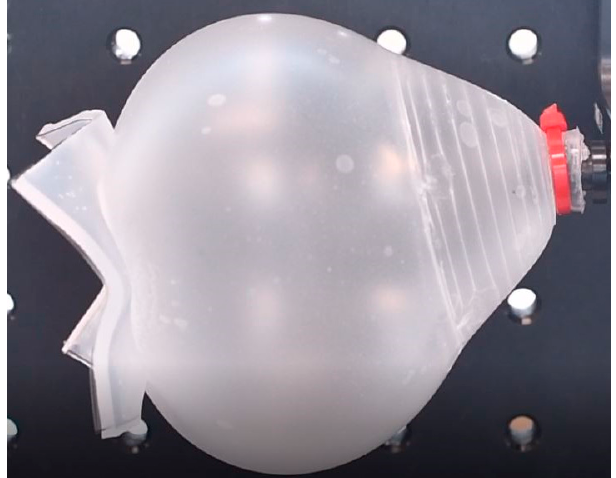
Figure 8. Pressure test sample inflated to 33 kPa.